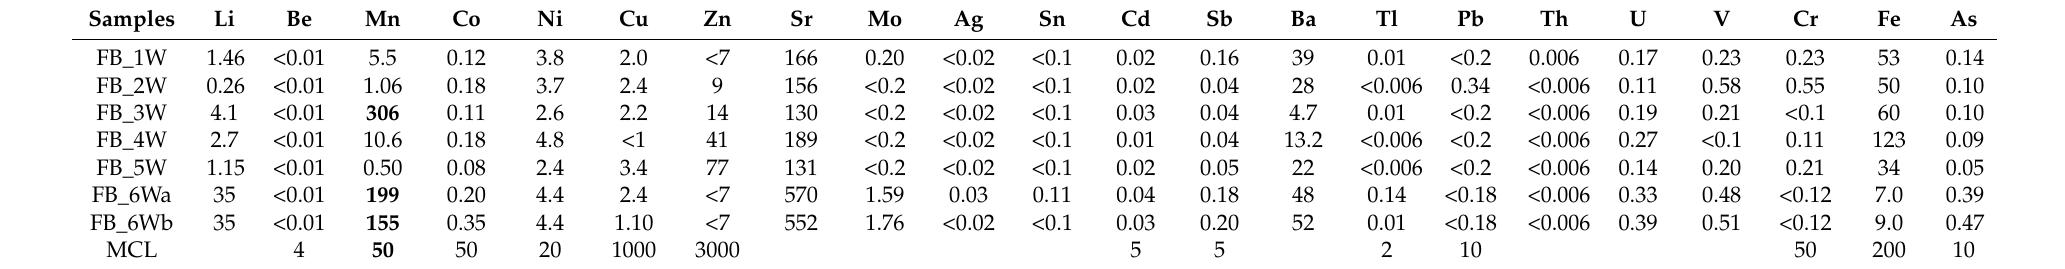
Table 4. Trace elements in groundwater ( µ g/L) together with the maximum concentration level (MCL, µ g/L) imposed by Italian regulations (Legislative Decree No. 152/2006 approving the Code on the Environment). Values in bold exceed the concentration threshold for